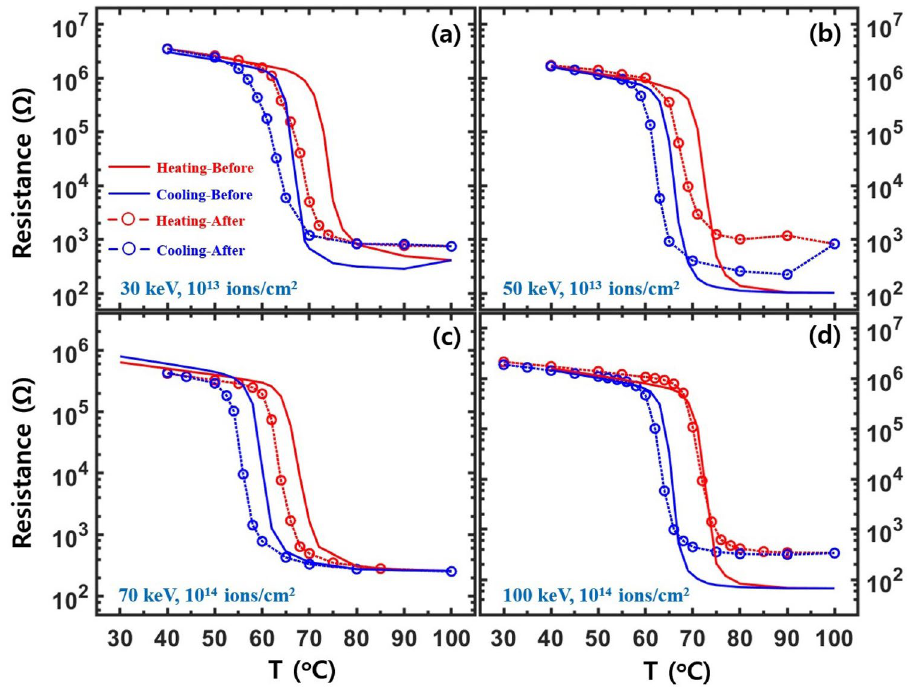
Figure 2. Temperature-dependent electrical resistance for Co-VO 2 films with a Co ion energy and a flux of ( a ) 30 keV and 10 13 ions/cm 2 , ( b ) 50 keV and 10 13 ions/cm 2 , ( c ) 70 keV and 10 14 ions/cm 2 , and ( d ) 100 keV and 10 14 ions/cm 2 , respectively. Solid lines and circles are the resistances for the same Co-VO 2 film before and after Co-ion implantation, respectively. XAFS was simultaneously measured at the temperatures of the circles. Red and blue colors indicate resistance for heating and cooling processes, respectively. The dotted lines are a guide for the